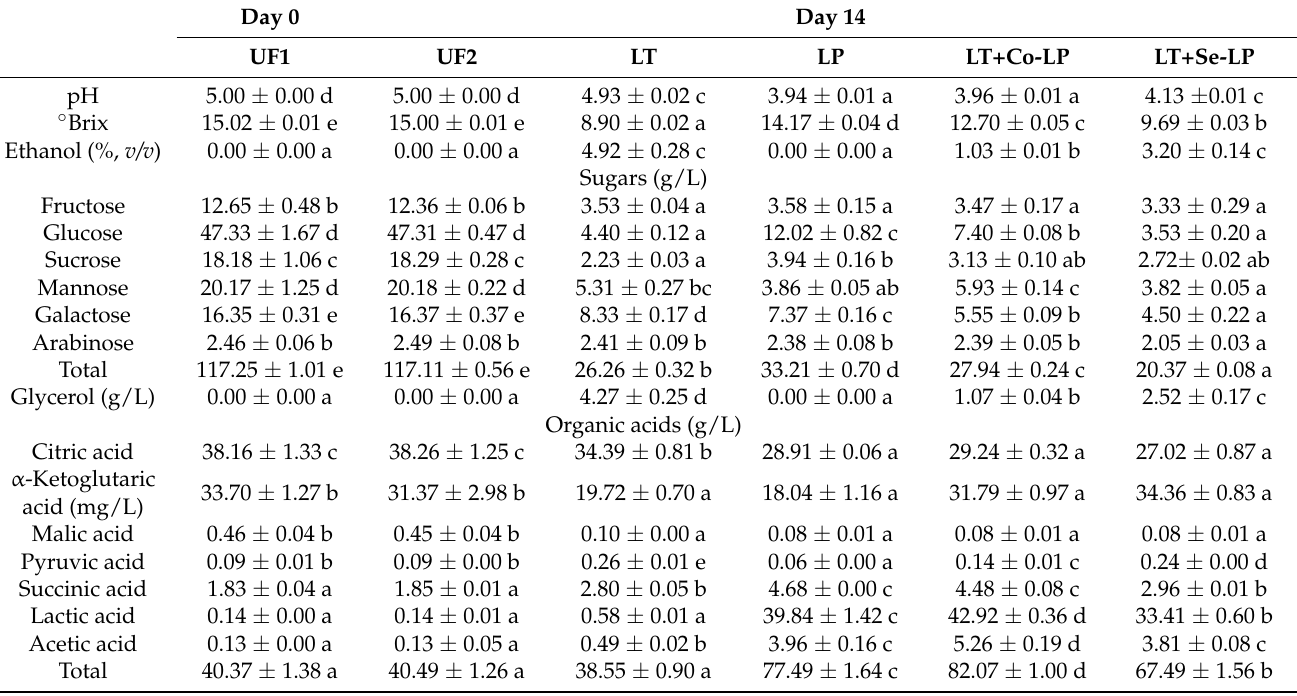
Table 1. Oenological parameters of SCG hydrolysates fermented with L. thermotolerans and L. plantarum